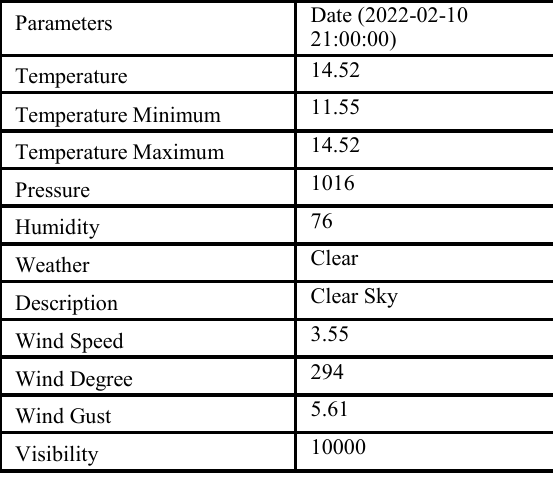
Table 4.4 Sample result of weather